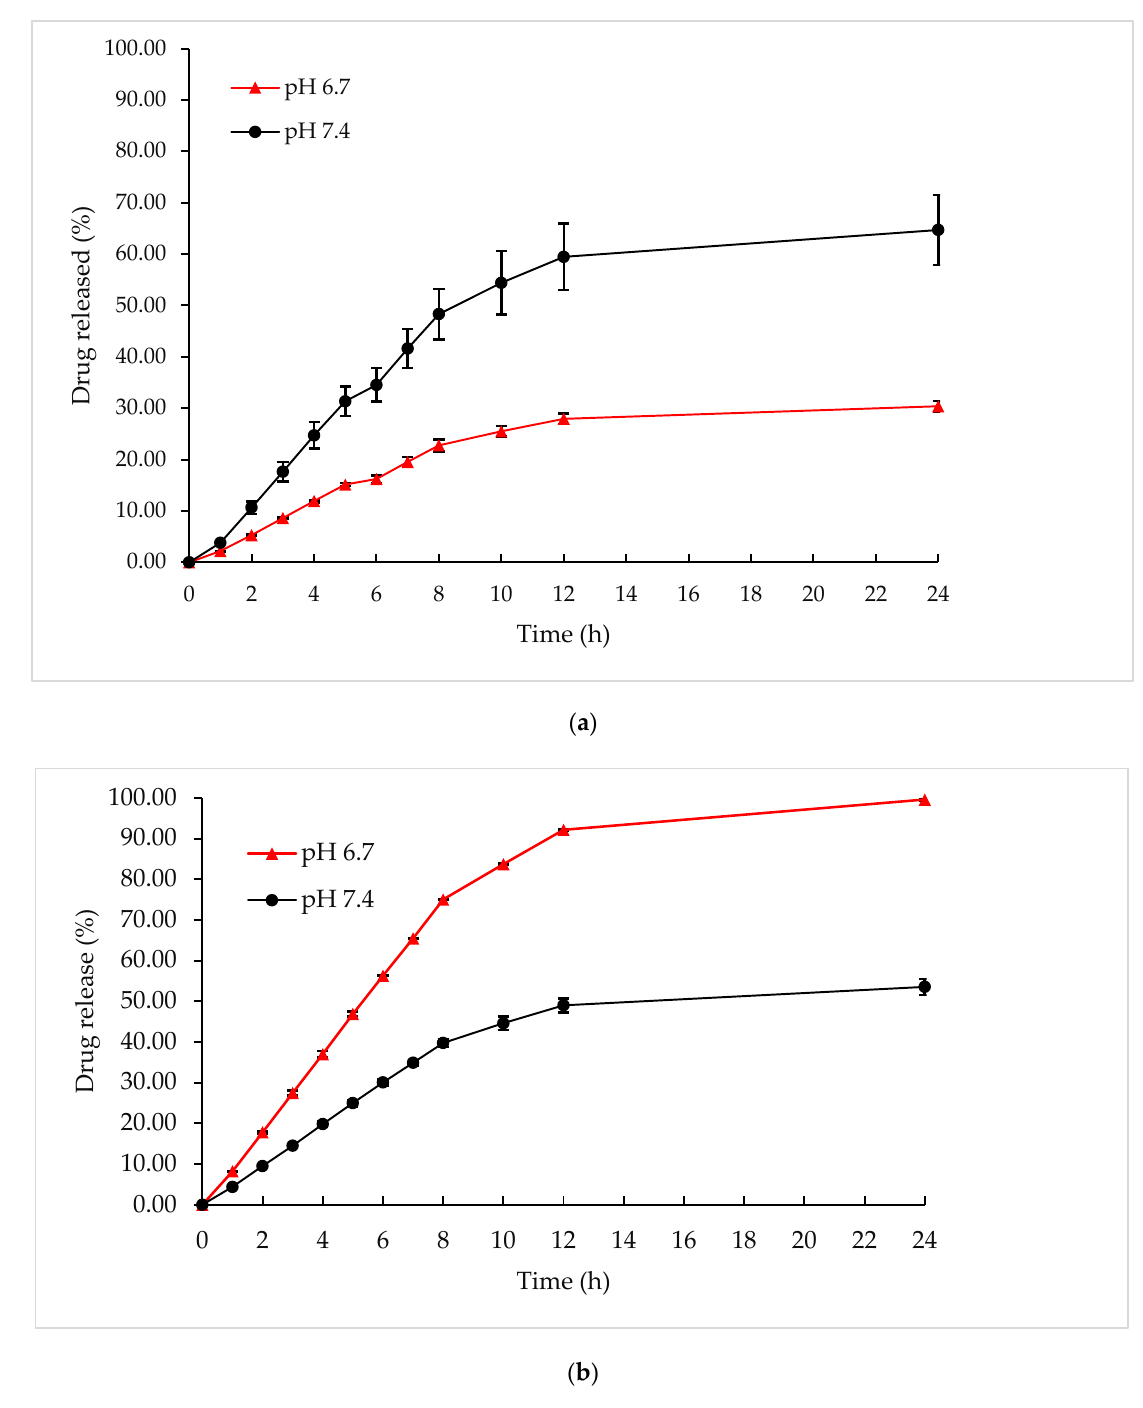
Figure 5. The cumulative release of ( a ) Gem and ( b ) Cis at different pH of SLF. The correlation coefficients ( R 2 ) of all kinetic models for Gem and Cis release from the optimized niosome at pH 7.4 and 6.7 are shown in Table 7. The permeation profiles of the niosome formulations followed the Higuchi model for both gemcitabine and cisplatin in SLF pH 7.4 (cumulative percentage of drug release versus square root of time), as the plot showed high linearity, with R 2 values of 0.9114 and 0.9129, respectively. In SLF pH 6.7, the gemcitabine release profile followed the Higuchi model (cumulative percentage of drug release versus square root of time) and the cisplatin release profile followed the Hixson–Crowell model (cube root cumulative amount of drug remaining versus time)